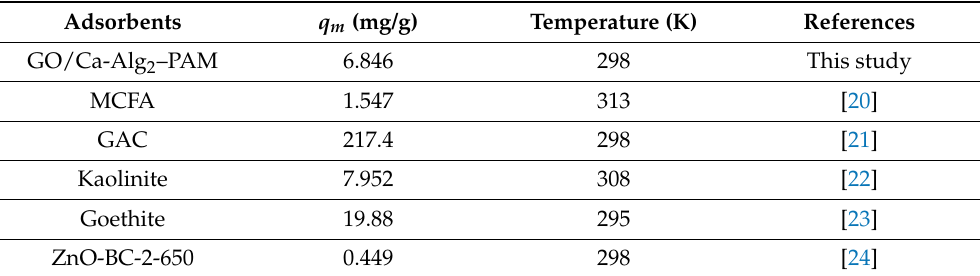
Table 2. Comparison of ciprofloxacin maximum adsorption capacity between this study and previous